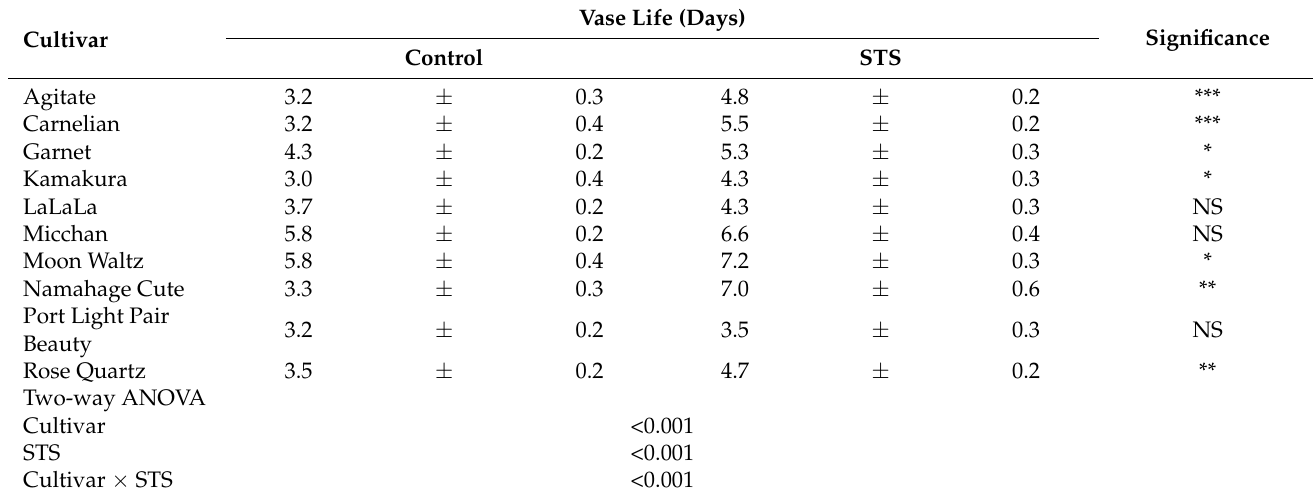
Table 2. Effect of pulse treatment with STS on the vase life of 10 dahlia cultivars.